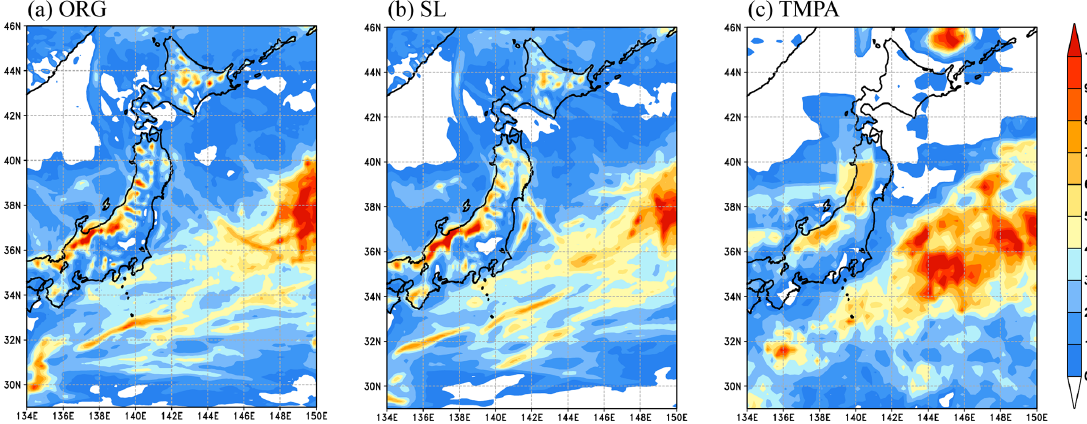
Figure 9. Average precipitation over the total integration period (16 days) from the (a) ORG run, (b) SL run, and (c) TMPA.